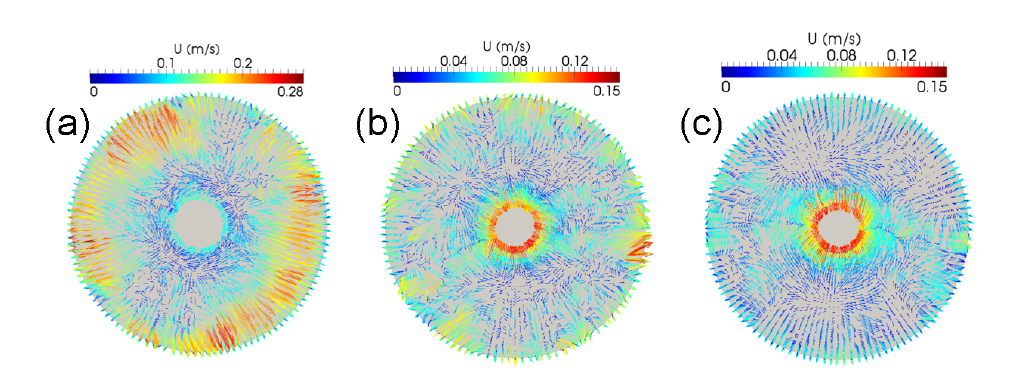
Figure 3. Lorentz force density distribution in the melt in the vertical plane ( y = 0) for ( a ) Case 1, ( b ) Case 2, and ( c ) Case 3.